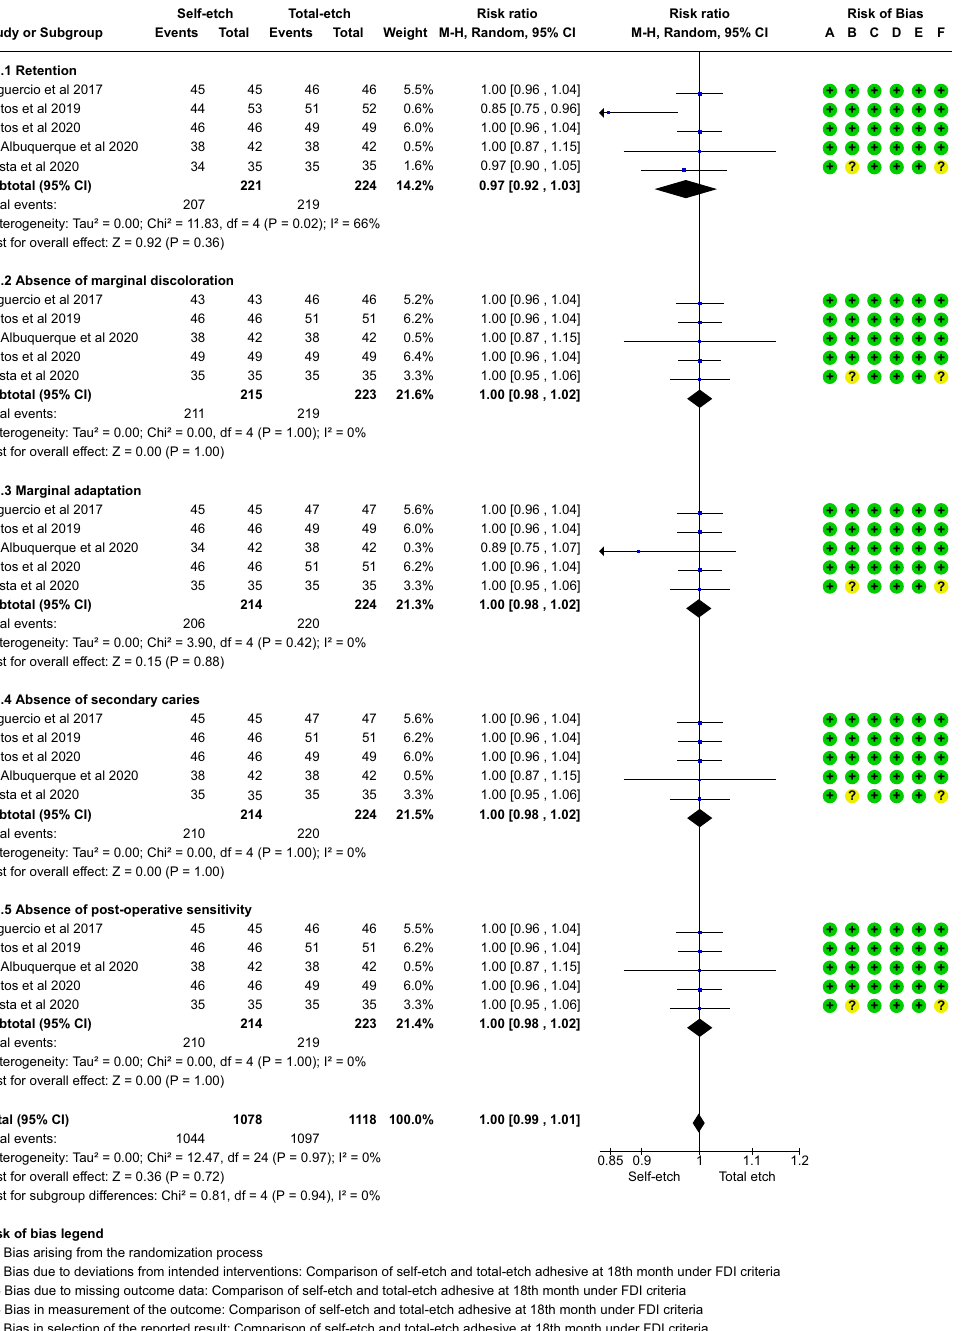
Fig. 5 Forest plot representing the pooled events at 18months using FDI criteria. No signi fi cant difference observed between total etch and self-etch adhesive strategies for any of the